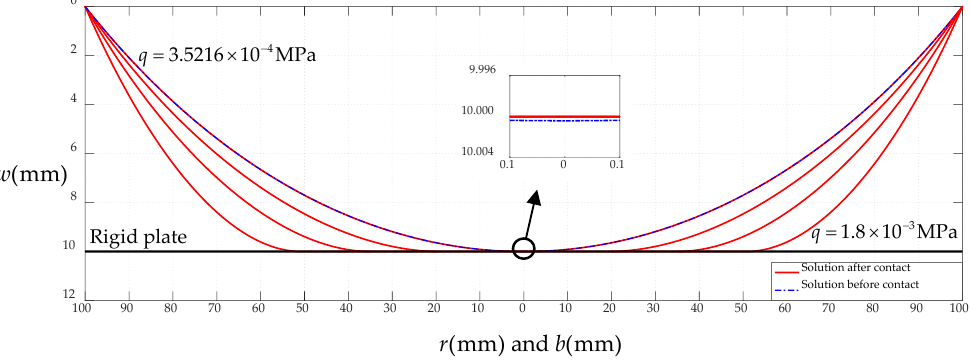
Figure 9. Sketch from contact deflection to free deflection, where the parallel gap g keeps 10 mm and the loads q decreases from 1.8 × 10 −3 MPa to 8.3843 × 10 −4 MPa, then to 4.9431 × 10 −4 MPa, and finally to 3.5216 × 10 −4 MPa.